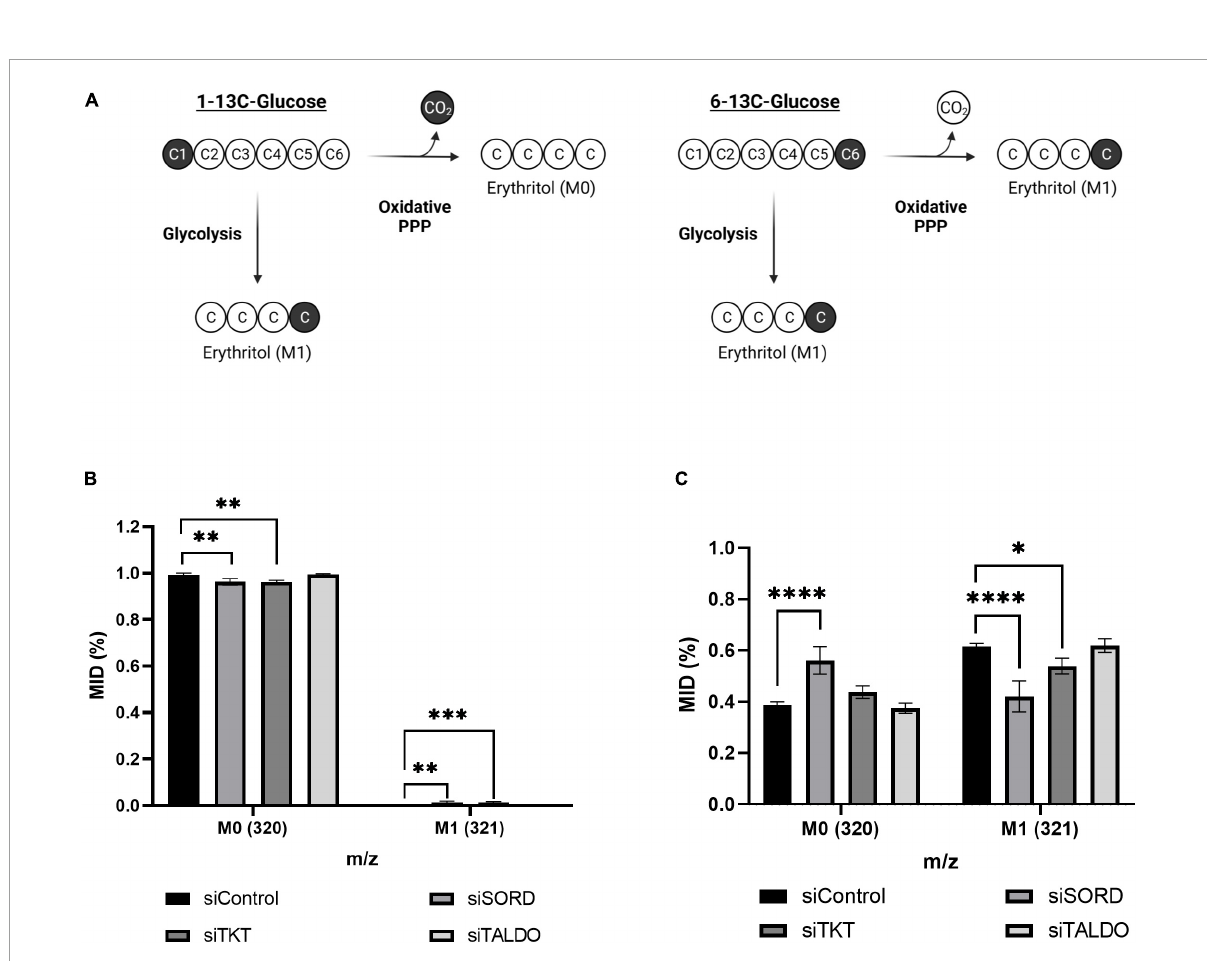
FIGURE6 Erythritol carbons are derived from the oxidative PPP, not directly from glycolysis. (A) Representation of differential incorporation of 13 C into erythritol from 1-[ 13 C] or 6-[ 13 C]-glucose. (B) MID of unlabeled (M0) and labeled (M1) erythritol after incubation with 25 mM 1-[ 13 C]-glucose. (C) MID of unlabeled (M0) and labeled (M1) erythritol after incubation with 25 mM 6-[ 13 C]-glucose. Data is shown as mean ± SD, n = 4–5, and was analyzed by two-way ANOVA with Dunnett’s multiple comparisons test. ∗ p < 0.05, ∗∗ p < 0.01, ∗∗∗ p < 0.001, ∗∗∗∗ p < 0.0001. ATUB, alpha tubulin; MID, mass isotope distribution; SORD, sorbitol dehydrogenase; TALDO, transaldolase; TKT,